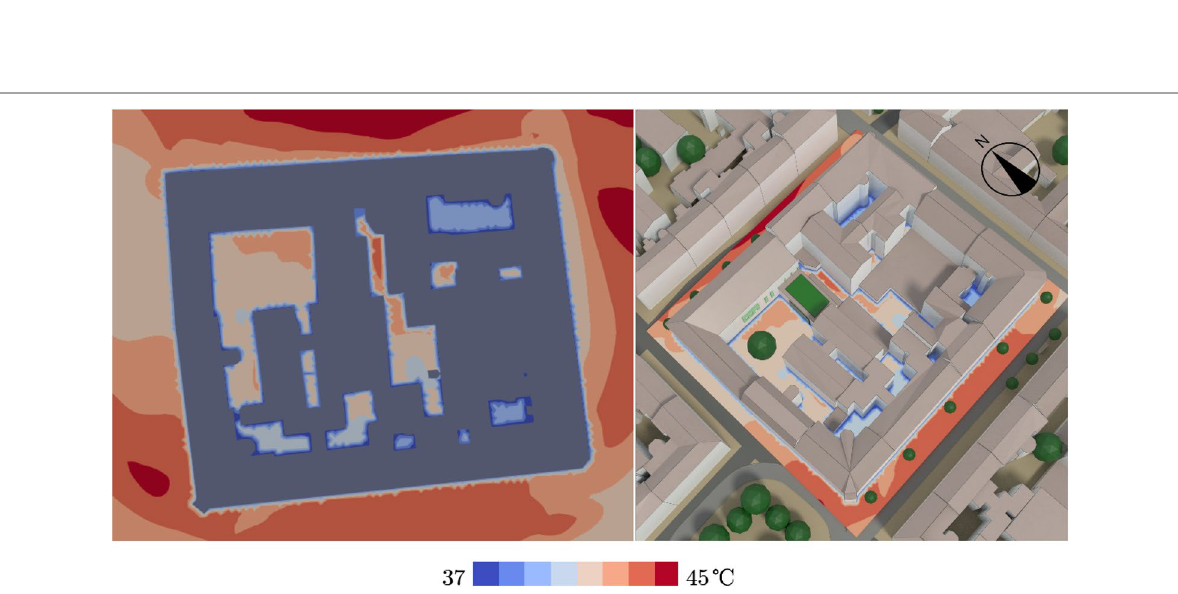
Fig. 15 Apparent temperature (Steadman 1994) of the simulation case Kandlgasse, 1.5 m above the ground at 14:00 CEST on 01 August